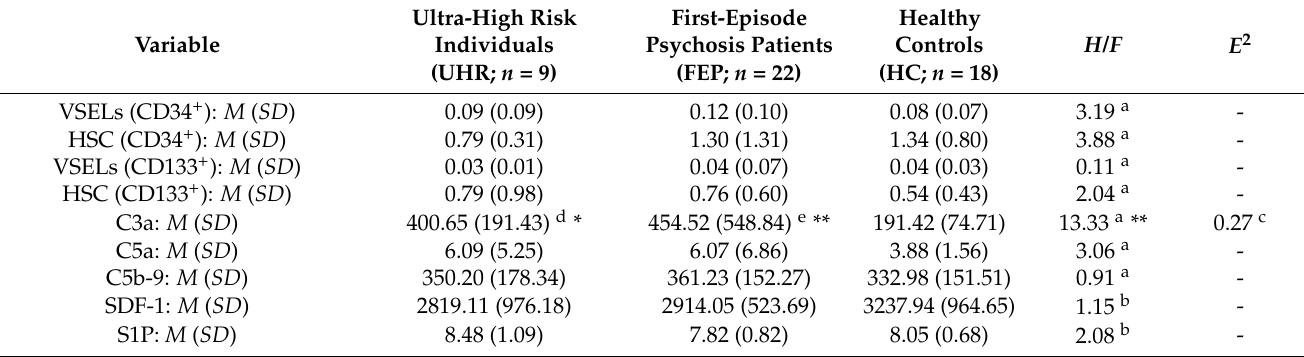
Table 2. Comparison of biological parameters between participants from the three